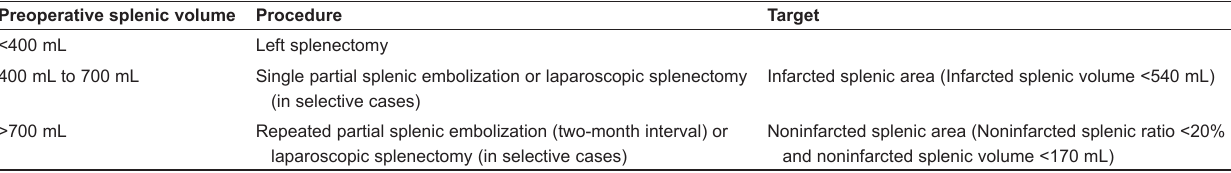
Table 2 Management of thrombocytopenia due to cirrhosis at a single centre Preoperative splenic volume